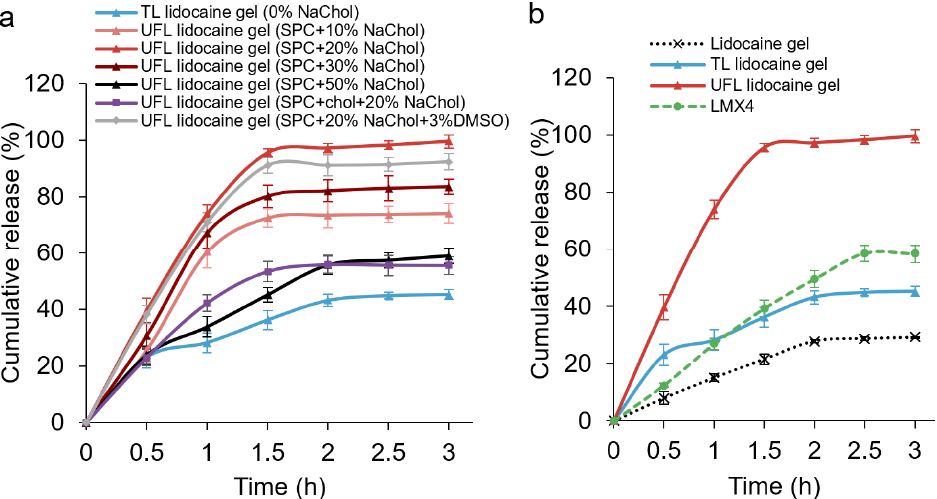
Figure 1. Permeation profiles through Strat-M membranes of ( a ) 50 mg different formulations of liposomal gels and ( b ) lidocaine-containing carbomer gel, LMX4 cream, TL and UFL lidocaine gels.